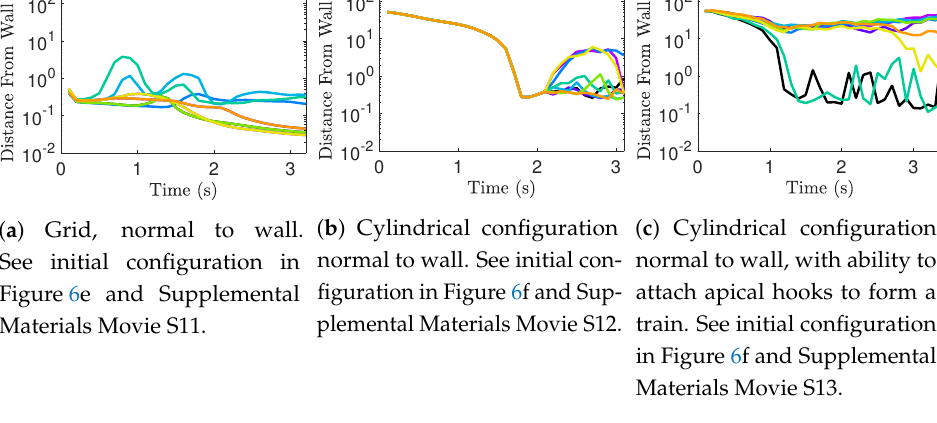
Figure 20. Distance between the head point of the flagellum and the wall over time for 9 swimmers initialized in planes normal to the wall. In panel ( a ), we show swimmers initialized in a grid but with planes normal to the wall. Here, as expected, we see the swimmers moving mostly towards the wall over time. We can contrast that with panel ( b ), which are also initialized in planes normal to the wall but the flagella are in a cylindrical configuration, as in Figure 6f. Lastly, panel ( c ) shows the results of swimmers initialized in a cylindrical configuration, as in Figure 6f, but with the ability to “hook” onto each other and form a train. Again, they initially swim towards the wall, but some swim away after about 1 s, or 10 beats. Color of curves indicates data for flagellum of matching color from Figure